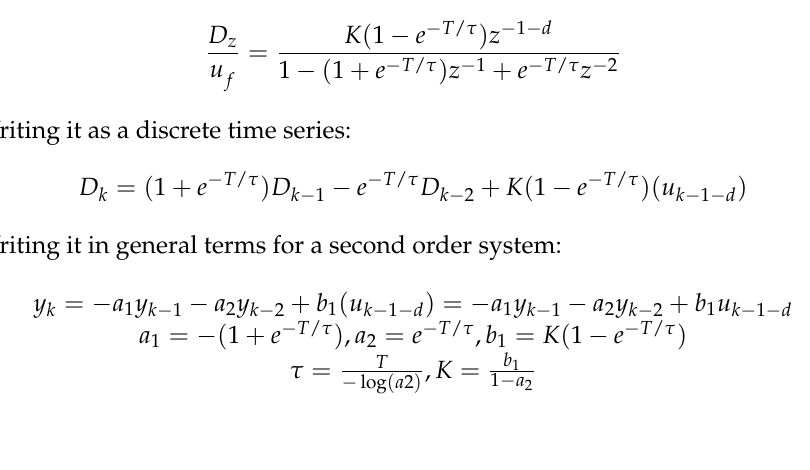
Determination of delay time d: the delay time of the system is the minimum of the variance of the residual error. Table 4 shows the variance of the corresponding residuals when d is taken at different values.